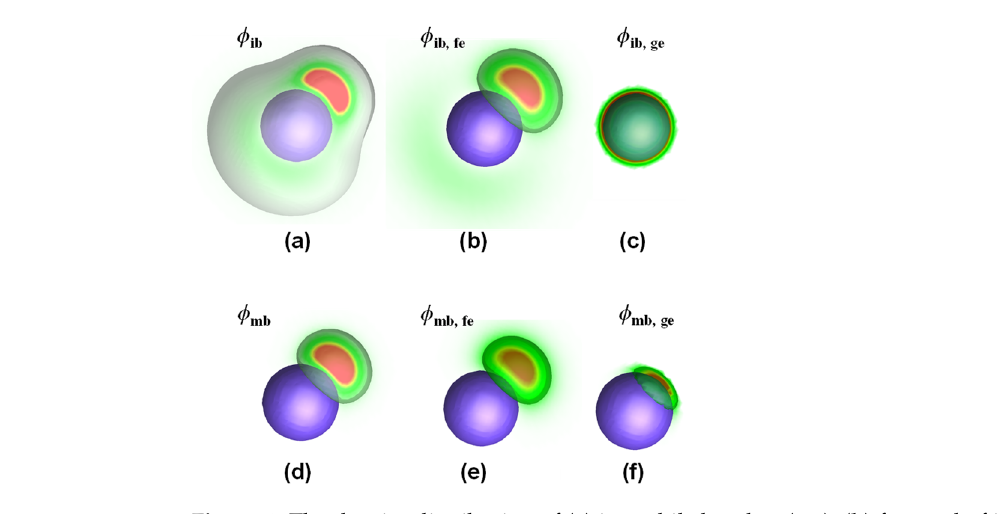
Figure 4. The density distribution of ( a ) immobile brushes ( φ ib ), ( b ) free end of immobile brushes ( φ ib,fe ), ( c ) grafted end of immobile brushes ( φ ib,ge ), ( d ) mobile brushes ( φ mb ), ( e ) free end of mobile brushes ( φ mb,fe ), and ( f ) grafted end of mobile brushes ( φ mb,ge ) in a single-patch nanoparticle ( P 1 ). The blue sphere denotes the nanoparticle, and the colors range from green (low density) to red (high density) in the density distribution.